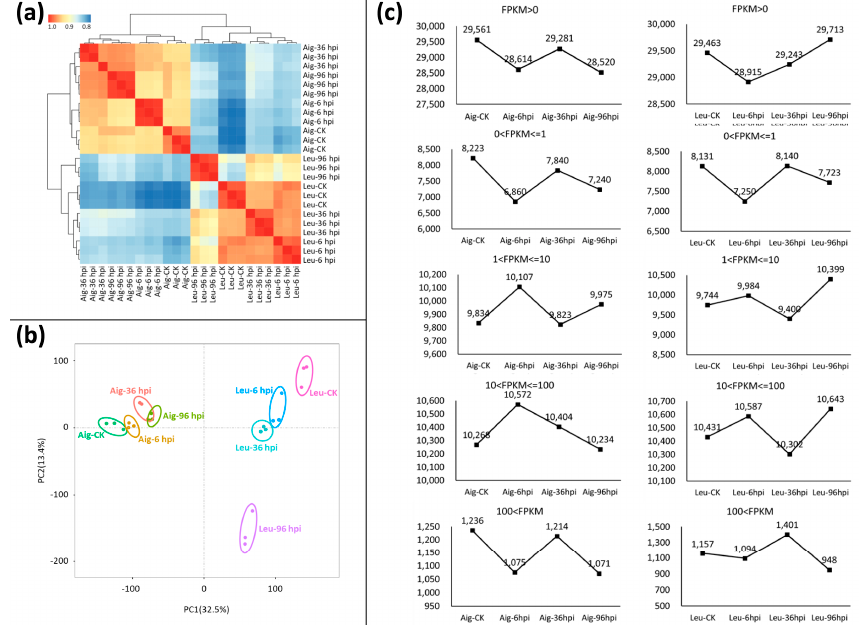
Figure 2. Correlation among RNA-seq samples, and distribution of gene expression values in two poplars. ( a ) Heat map of the Pearson correlation of sequenced samples based on gene expression level. Clustering was conducted according to the expression data of all expressed genes. ( b ) Principal component analysis (PCA) of transcript levels of RNA-seq samples. The analysis was performed on R using the expression data of all expressed genes. ( c ) Distribution of gene expression values among developmental stages examined. The FPKM value of each gene was calculated by the average of FPKM values of three biological replicates. FPKM: fragments per kilobase of exon per million fragments